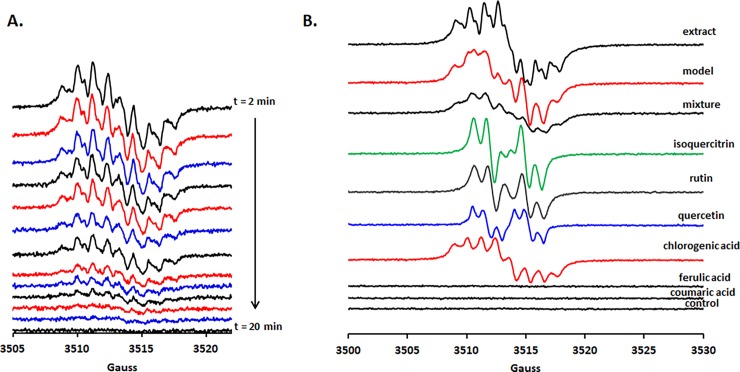
Probing the polyphenolic components and alkali-generated radicals reactivity in the studied extract using EPR spectroscopy.A. Time dependence of such generated radicals between 2 min (dead time due to spectrometer calibration prior measuring) and 20 min, at about 1.8 minutes interval. B. The dominant spectral fingerprint of the chlorogenic acid is visible in the extract with minor contributions of rutin and quercetin. Ferulic and coumaric acids gives no EPR spectrum while treated with sodium hydroxide as described in experimental section. The best fit for the EPR spectrum of the extract was obtained by a linear combination of the identified polyphenols in a 1/30/40 ratio (quercetin/rutin/chlorogenic acid) (model).